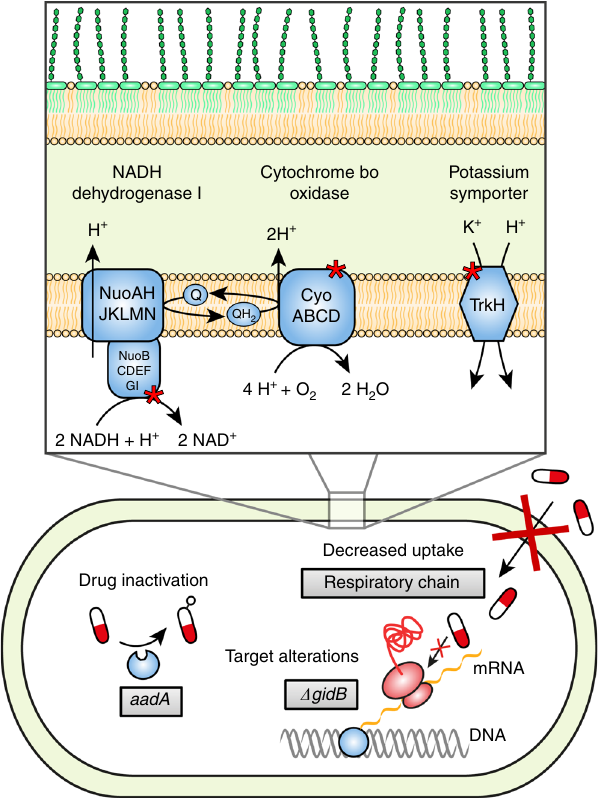
Fig. 6 Three different resistance mechanisms that act in synergy. Increased expression of the aminoglycoside adenyl transferase gene aadA via inactivation of the gene znuA lowers the concentration of active drug through chemical modi fi cation, mutations in gidB indirectly modi fi es the drug target to decrease binding, and mutations in the respiratory chain lowers the membrane potential, causing a decrease in uptake of the